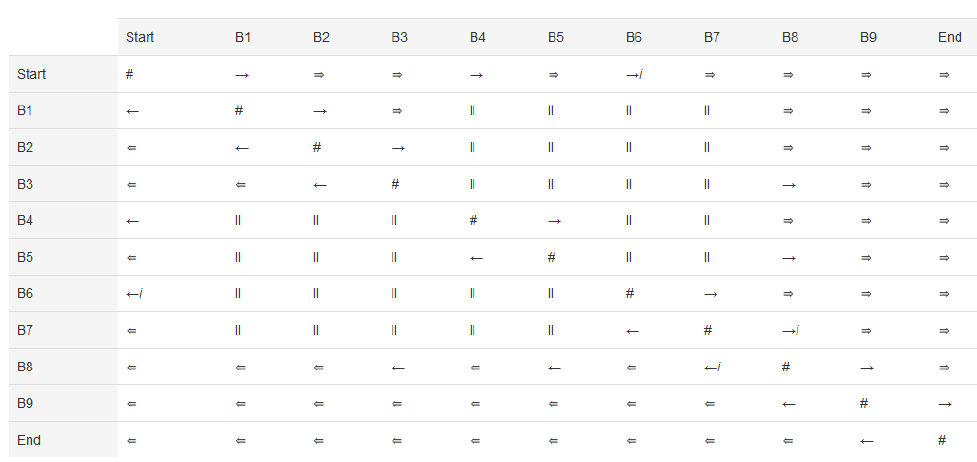
Figure 14. Footprint relation after the two performed scenarios shown in Figure